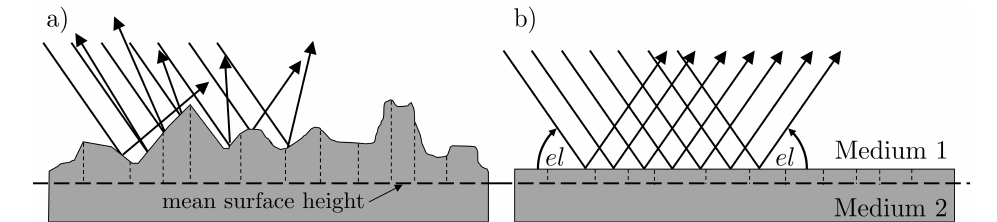
Figure 11. ( a ) Diffuse reflection at a rough surface. ( b ) Specular reflection at a smooth surface. In ( a ) and ( b ), the horizontal dashed line represents the mean surface height, and the vertical dashed lines are the differences from the mean surface height.